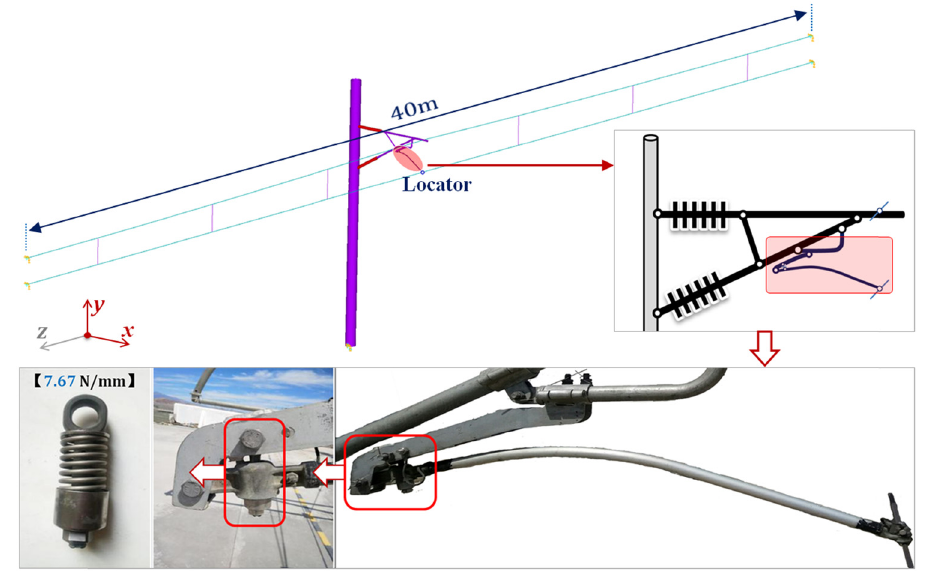
Figure 7: Catenary components and positioning spring